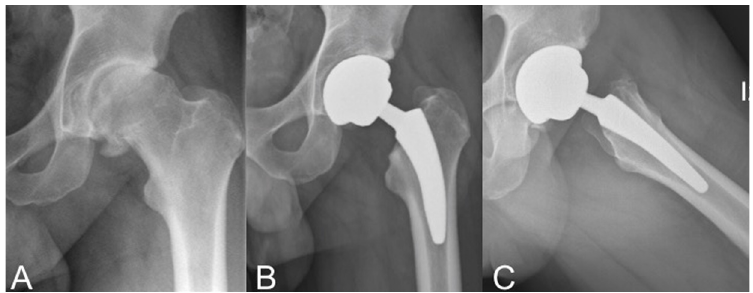
Figure 1. A. Preoperative anteroposterior radiographs of a 43-yeard old male ’ s left hip with diagnosis of primary osteoarthritis. B and C. postoperative anteroposterior (A) and lateral (B) radiographs showing adecuate implant positioning after implanting a MiniHip TM stem.